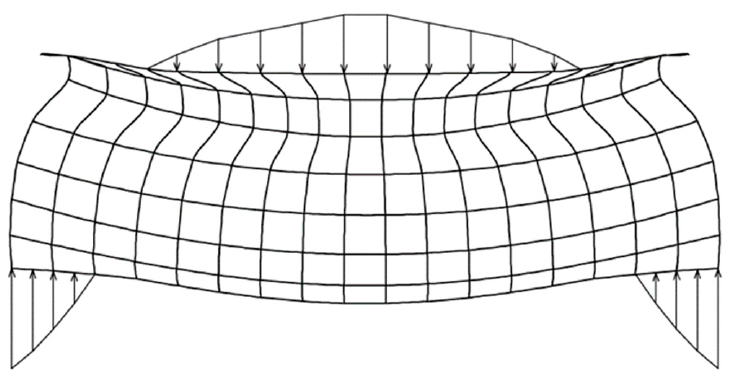
Figure 12. Diagram of ETDNO pressure distribution at dorsal and volar aspects of the